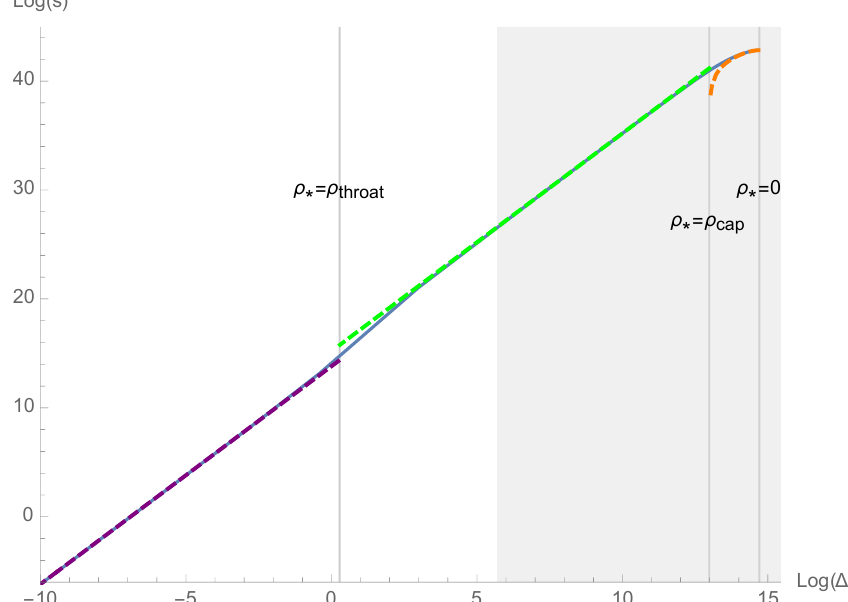
Figure 8. The solid blue line is the full numeric answer for the center-of-mass energy, while the dashed lines are the analytic approximations in the respective regimes. In the grey area, the tidal forces become large. The parameters used are n = 3 , a = 10 − 3 , b = ε = 10 − 2